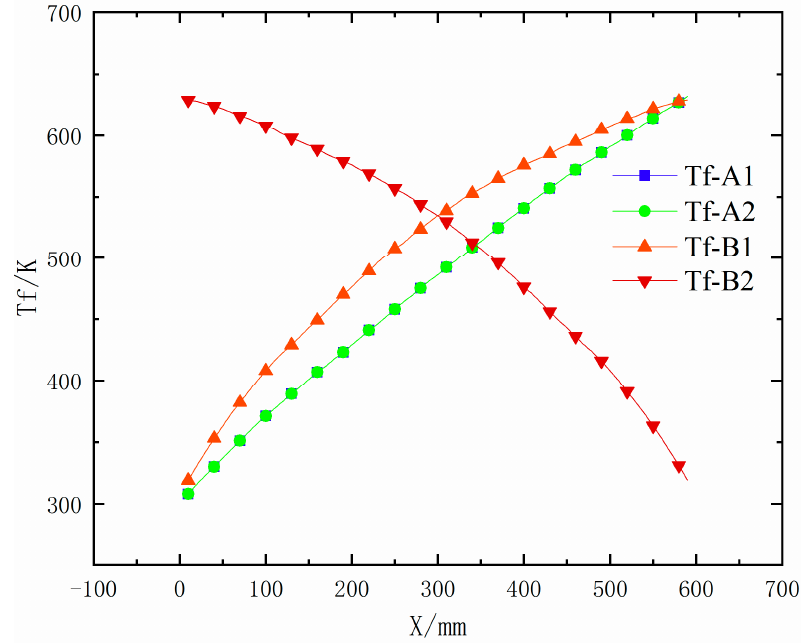
Figure 9. Bulk fluid temperature distribution along the X-axis.